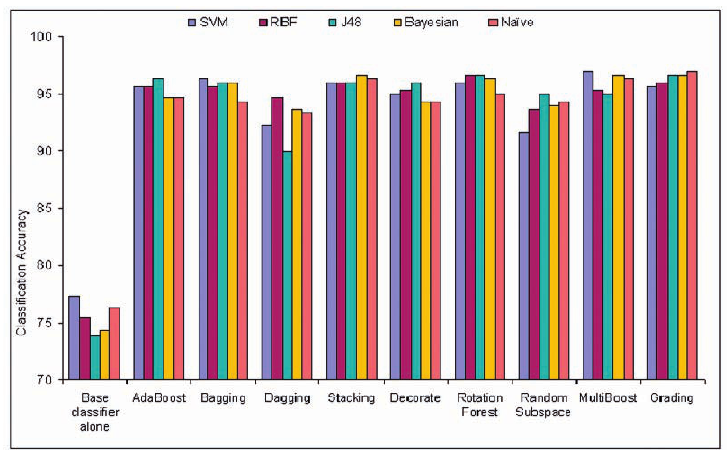
Figure 4. Classification accuracy of base classifiers alone vs. cascaded k -means C ensemble methods using